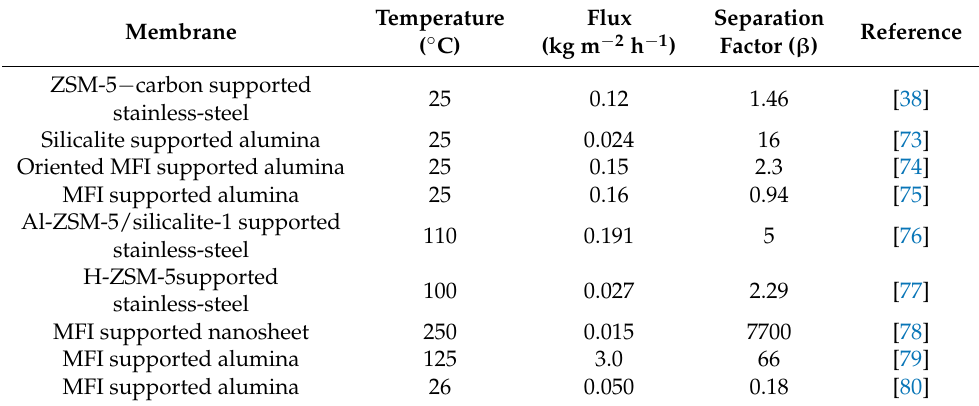
Table 3. Zeolite membranes studied for the separation of